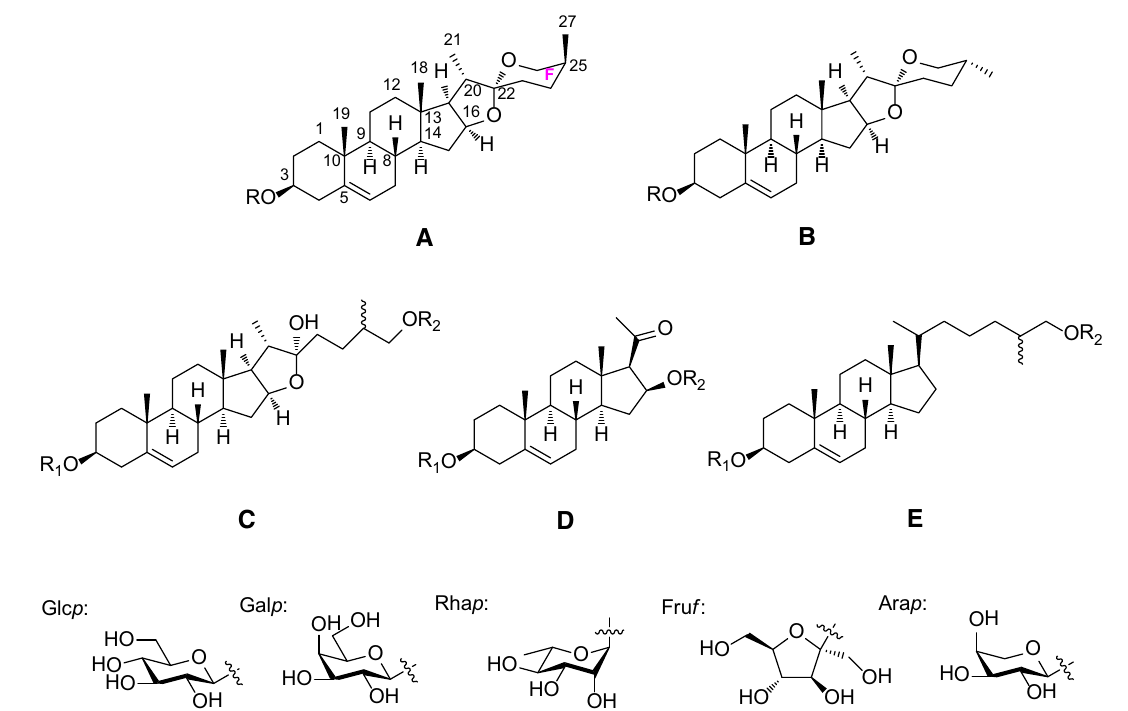
Fig. 1 Structures of a a spirostane backbone, b an isospirostane backbone, c a furostane backbone, d a pregnane backbone, e a cholestane backone, a glucopyranosyl moiety (Glc p ), a